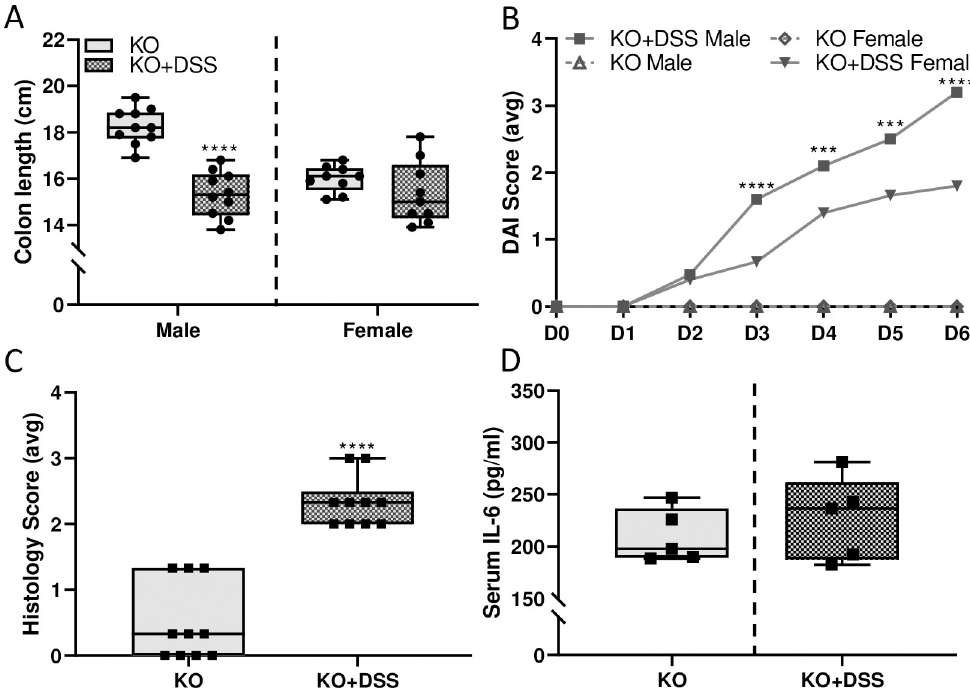
Fig 17. Acute DSS exposure causes colitis with GI tract-restricted inflammation in Hamp KO rats of both sexes. Length of the colon, defined as the end of the cecum to the anus, was measured as a macroscopic indicator of DSS-related intestinal damage in 10-week-old male and female Hamp KO rats ( A ). Data are presented as box plots for n = 7–11 rats/ group and were analyzed separately by sex using a t-test ( ���� p < 0.0001). Disease activity index (DAI) scores were also determined daily for rats of both sexes ( B ). Scores were averaged on each day for each group. Data for KO+DSS male and KO+DSS female were compared by two-way ANOVA with repeated measures (Day x Group, p < 0.001). Individual t-tests were then used to compare groups at each treatment day ( ��� p < 0.001; ���� p < 0.0001); mean values are shown for n = 7–11 rats/group. Histology scores from H&E-stained colonic sections from male rats are shown in panel C . Sections from the descending colon were blindly scored in 4 randomly selected areas. Each area was assigned a score from 0–4 based on levels of inflammatory cell infiltration, goblet cell depletion, and damage to the crypt/villus architecture. Data are presented as box plots for n = 10 rats/group and were analyzed by t-test ( ���� p < 0.0001). Serum IL-6 levels were assessed in male rats by ELISA ( D ). No significant difference (by t test) was noted between controls or DSS-treated rats (indicating a lack of systemic